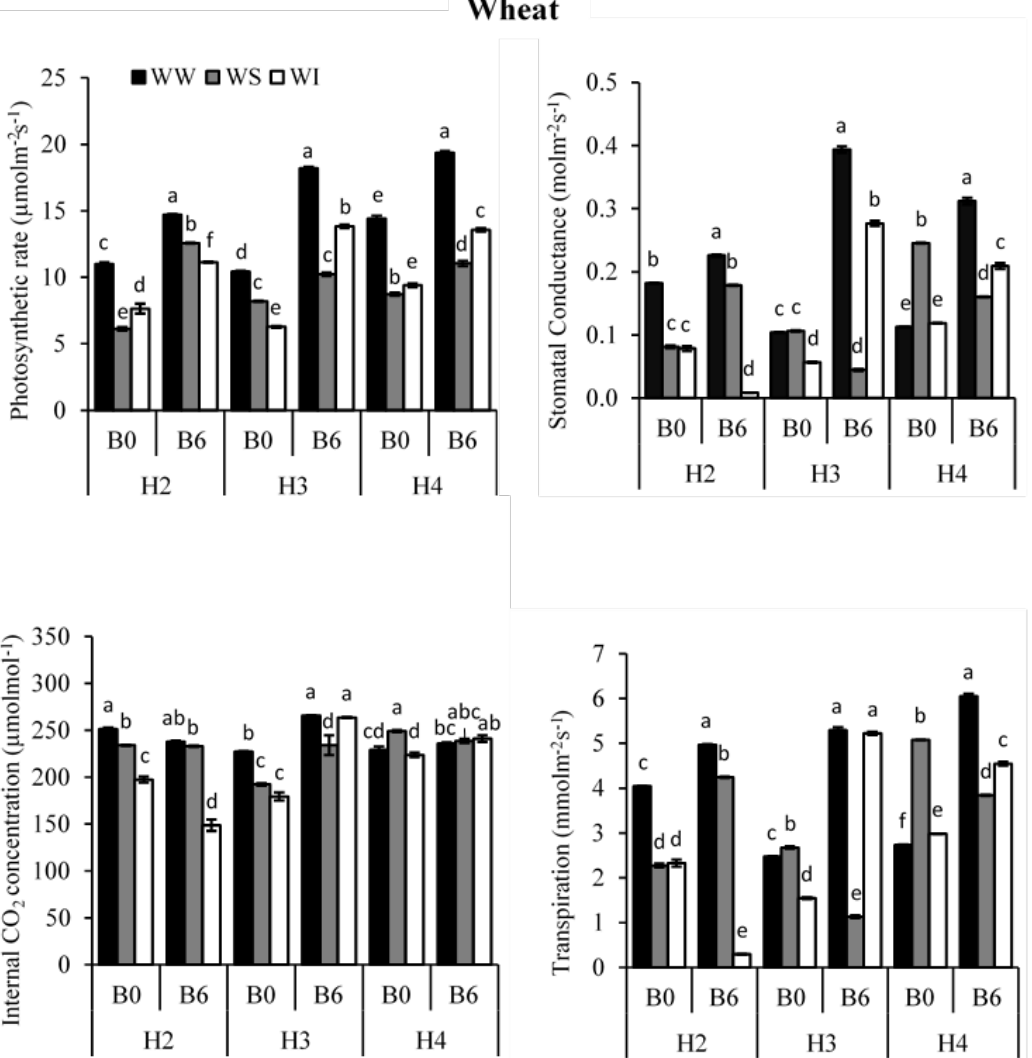
Figure 3. Effect of biochar and water regimes on photosynthesis ( µ molm − 2 s − 1 ), stomatal conductance (molm − 2 s − 1 ), internal CO 2 concentration ( µ molmol − 1 ) and Transpiration (mmolm − 2 s − 1 ) of wheat for the well-watered (WW); water-stressed (WS) and water intermittently (WI) treatments; at four harvest times; with 6 t ha − 1 biochar (B6) or without biochar application (B0); different letters on top of columns indicate a significant difference between treatments at p < 0.05 in each harvest.